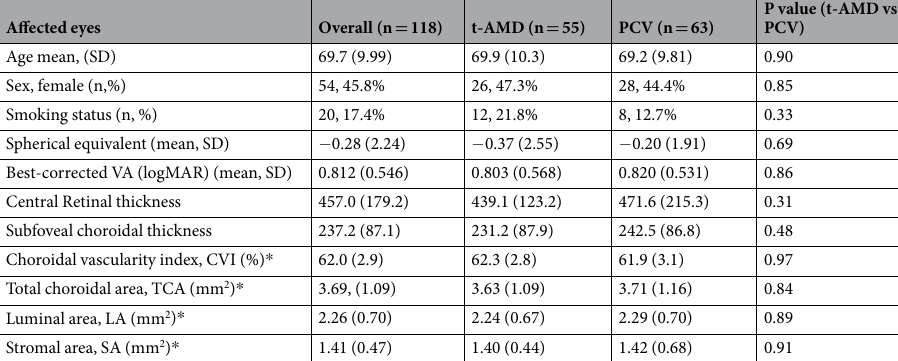
Table 1. Patients’ demographics, central retinal thickness, choroidal thickness (affected and fellow eye) and choroidal vascularity index (CVI) for typical AMD (t-AMD) and PCV patients. * CVI, TCA, LA and SA were calculated based on 98 eyes (47 t-AMD and 51 PCV), due to exclusion of 20 eyes that were